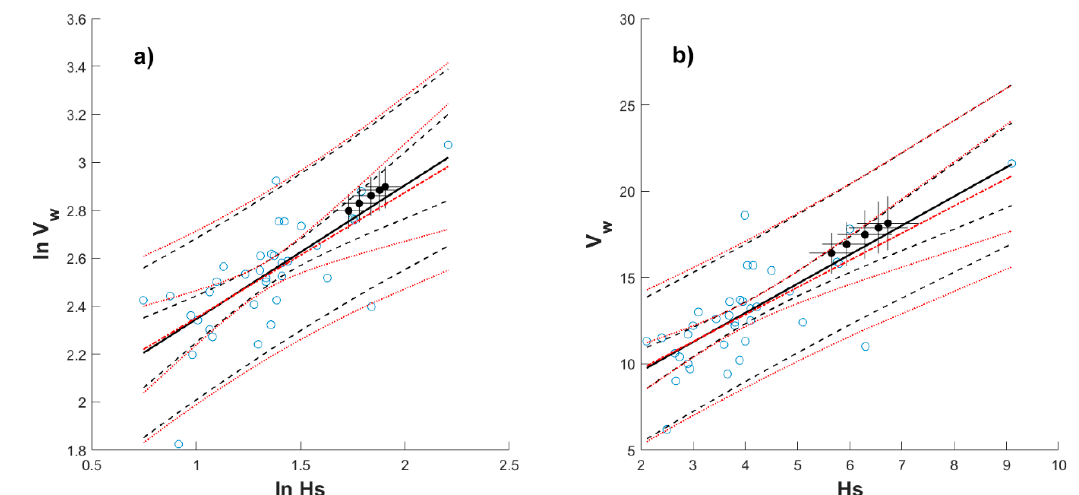
Figure A2. Regression lines and confidence intervals including (solid and dashed lines, respectively) and excluding (dashed–dotted and dotted lines, respectively) T -yr values for March; ( a ) and ( b ) for logarithmic space and linear space, respectively. Filled circles represent T -yr values with embedded perpendicular lines indicating confidence intervals from GEV models.